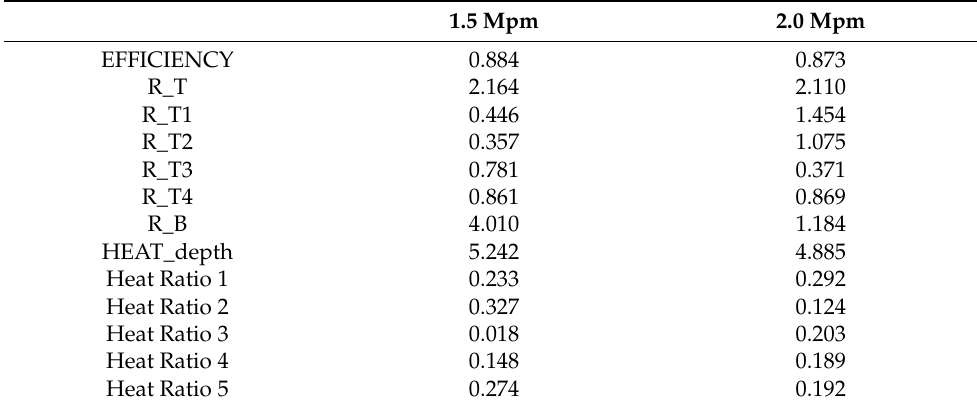
Table 4. Key parameters of welding heat source per welding speed.